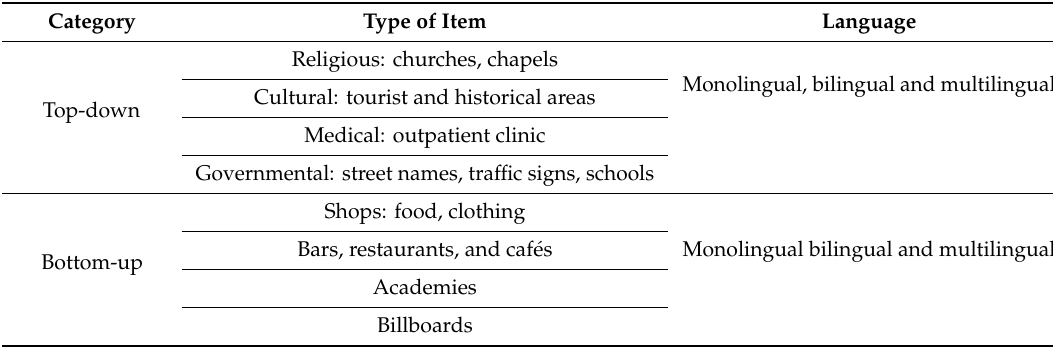
Table 1. Coding scheme.